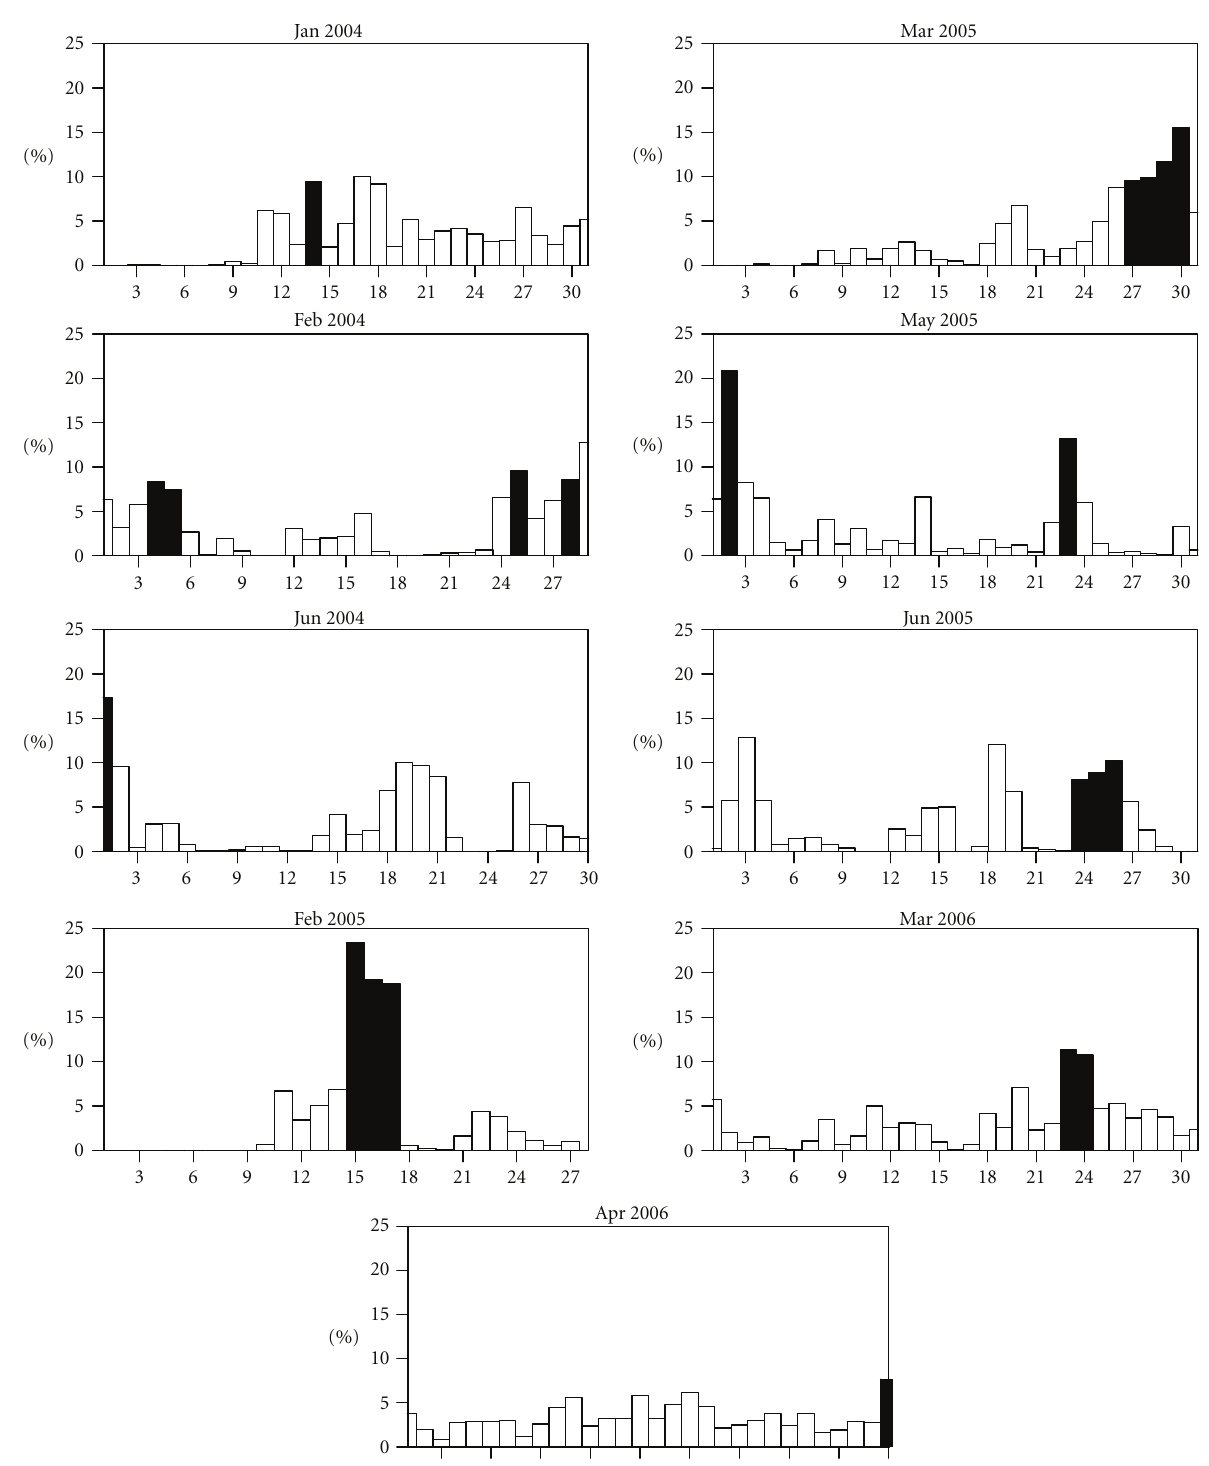
Figure 8: Ratio (%) between individual daily rainfall amount and monthly cumulative rainfall amount during the months when one or more selected events occurred. The twelve selected events (from 1-to-4 day duration; see Table 1) are marked by black